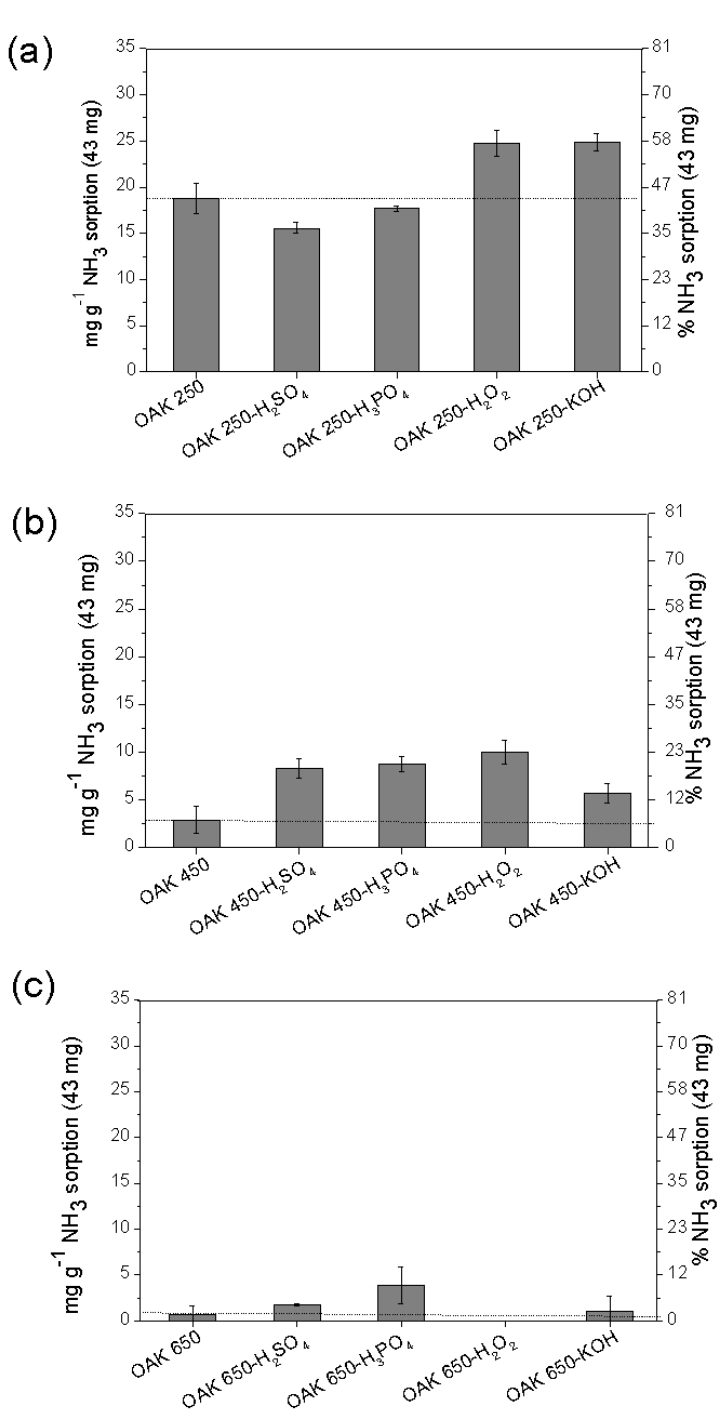
Figure 4. NH 3 sorption by ( a ) treated oak 250 °C hydrochar; ( b ) treated oak 450 °C biochar; and ( c ) treated oak 650 °C biochar d3 mg NH 3 gas generated according to Equation (2). Error bars represent deviation around the mean. For statistical analysis please refer to supplementary material Tables S4 – S6.